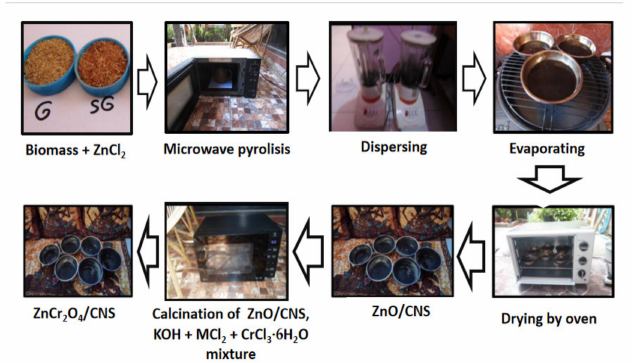
Figure 1. Steps in the synthesis of intermediate (ZnO/CNS) and final products using microwave (MCr 2 O 4 /CNS).